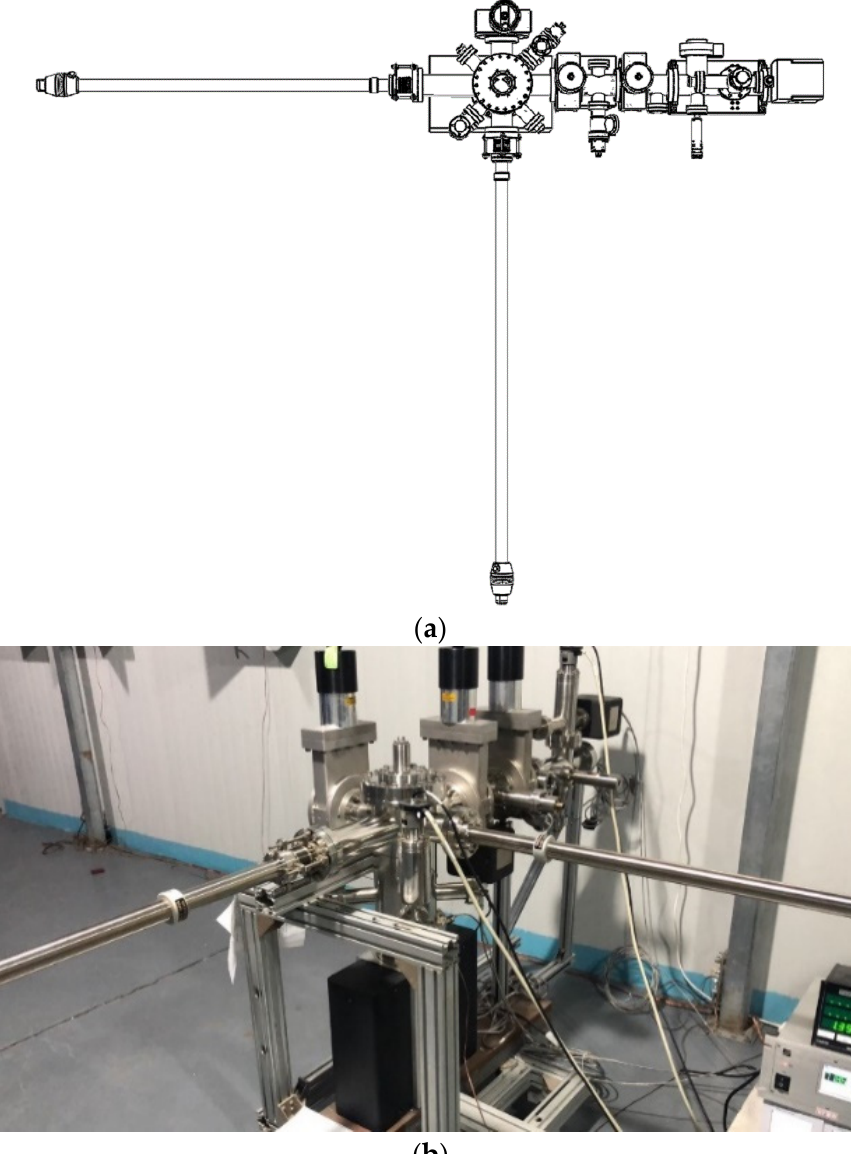
Figure 6. The schematic ( a ) and picture ( b ) of the transferring chamber, load lock and the transport suitcase at SARI. suitcase at